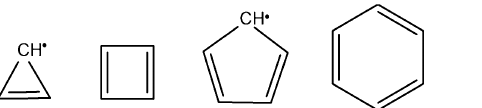
Figure 1. Chemical structures of cyclopropenyl radical, cyclobutadiene, cyclopentadienyl radical and benzene compounds.